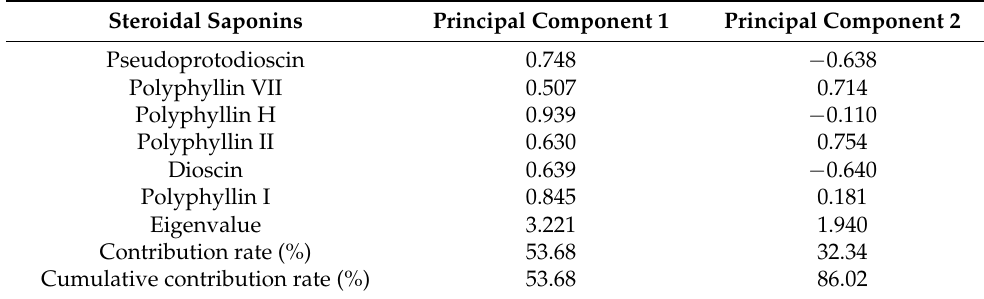
Table 1. Matrix of the principal component analysis of the steroidal saponins of P. polyphylla var. yunnanensis .